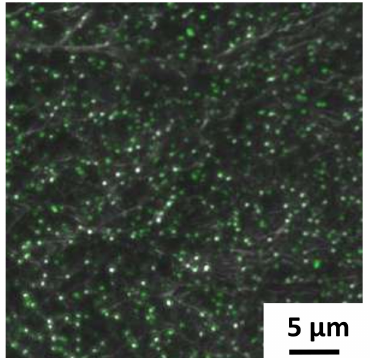
Figure 6. Confocal image of FITC functionalized silver doped carbon nanofibers fiber after being placed in microfluidic channel.